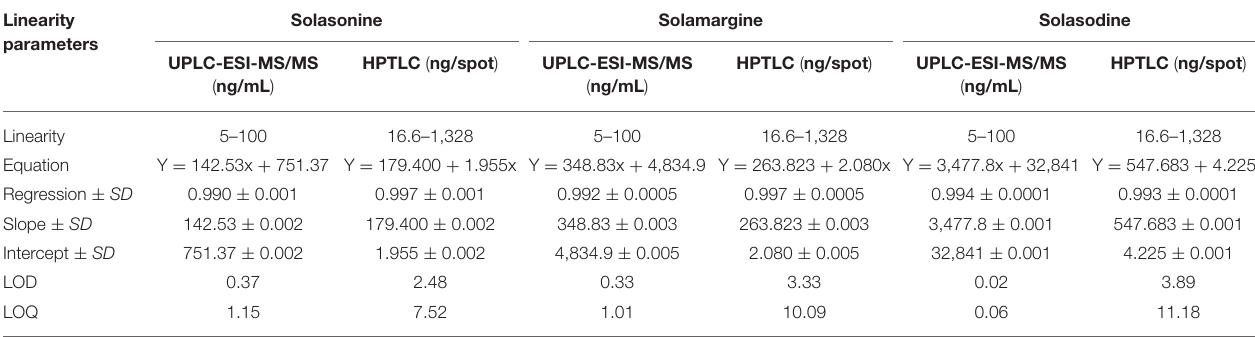
TABLE 3 | Linearity data of chromatographic UPLC-ESI-MS/MS and HPTLC Method for mixed standards ( n = 3). Linearity parameters